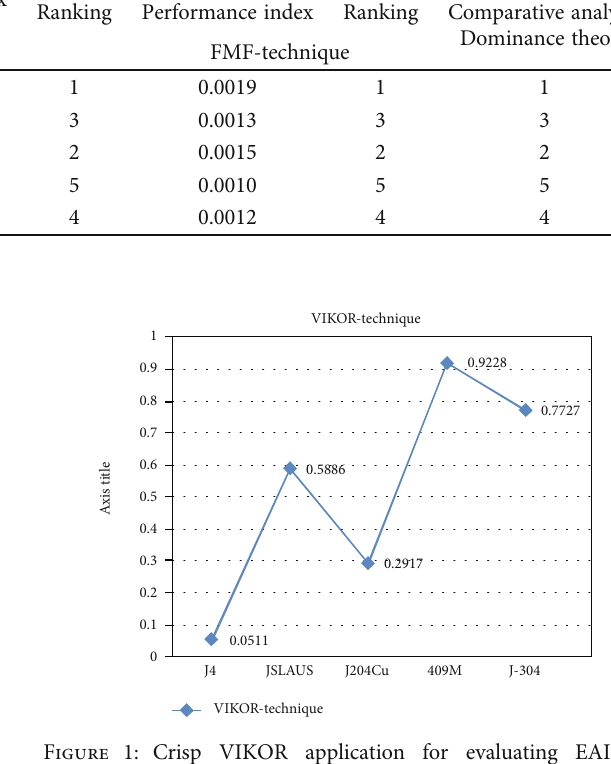
Table 10: Tabulated cumulative values EAI with rankings.